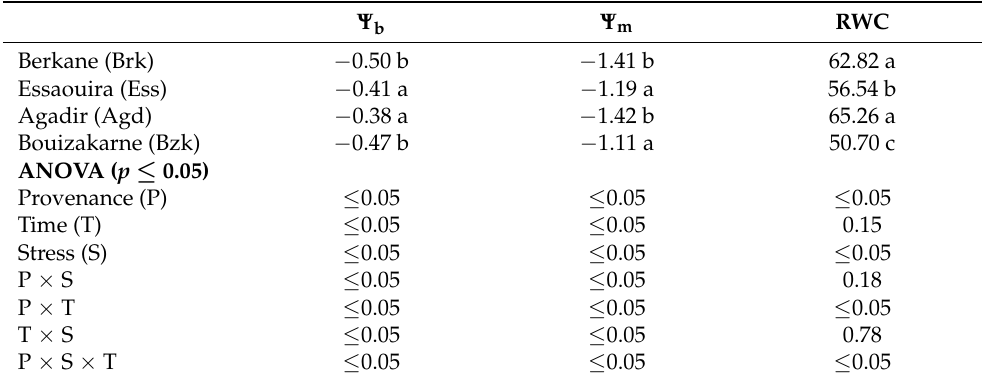
Table 1. Analysis of variance (ANOVA) showing the effect of provenance, observation time, and drought stress and their interaction on the physiological parameters studied in the four contrasting provenances of the A. spinosa (Berkane, Essaouira, Agadir, and Bouizakarne). Ψ Ψ m b Berkane (Brk)